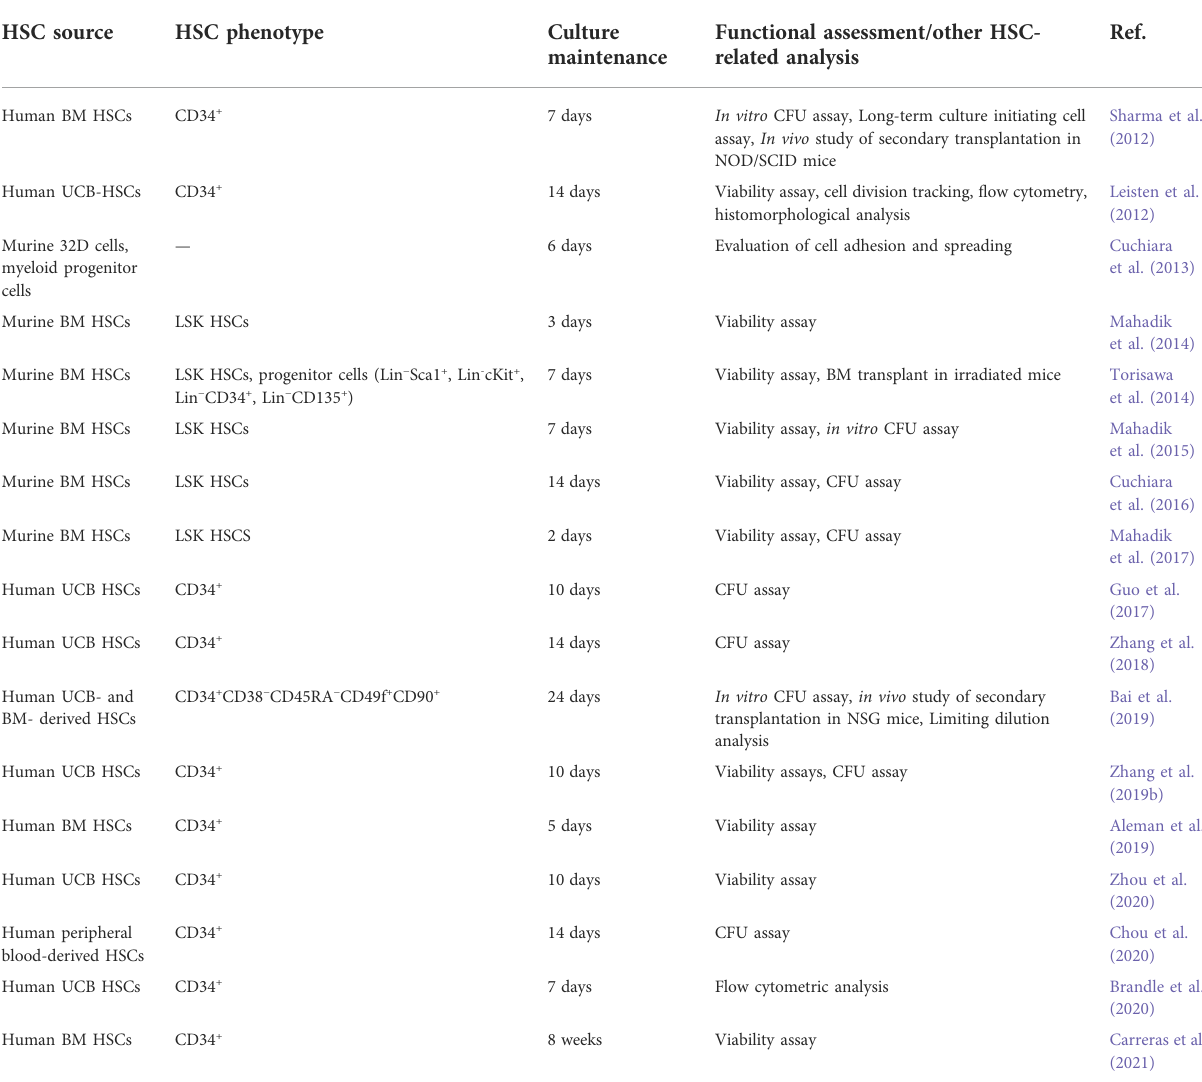
TABLE 2 Some hydrogel-based studies for in vitro HSC culture and